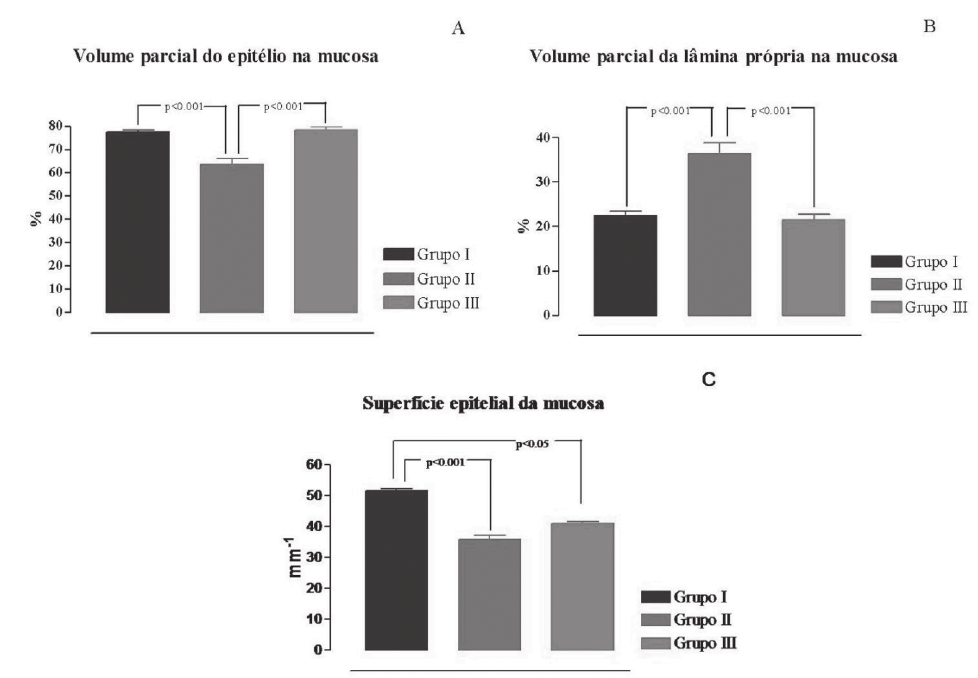
FIGURA 5 – Variações dos volumes parciais do epitélio da mucosa (A), da lâmina própria da mucosa (B) e da superfície epitelial da mucosa do cólon (C), entre os grupos controle (I), irradiado (II) e irradiado com suplementação de L-glutamina (III) Na tabela 1, pode ser observado um resumo dos dados numé- ricos encontrados para cada variável em cada grupo de estudo. Os resultados estão expressos em média ± erro